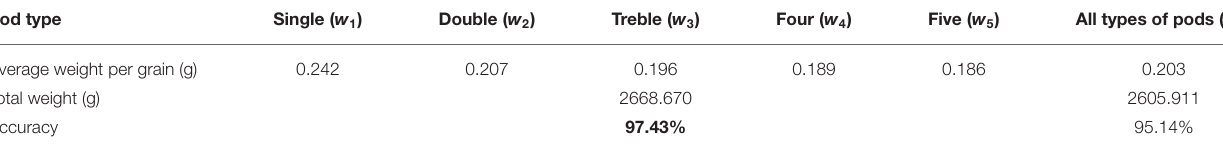
TABLE 3 | Weight of single soybean grain of different pod types and total yield prediction